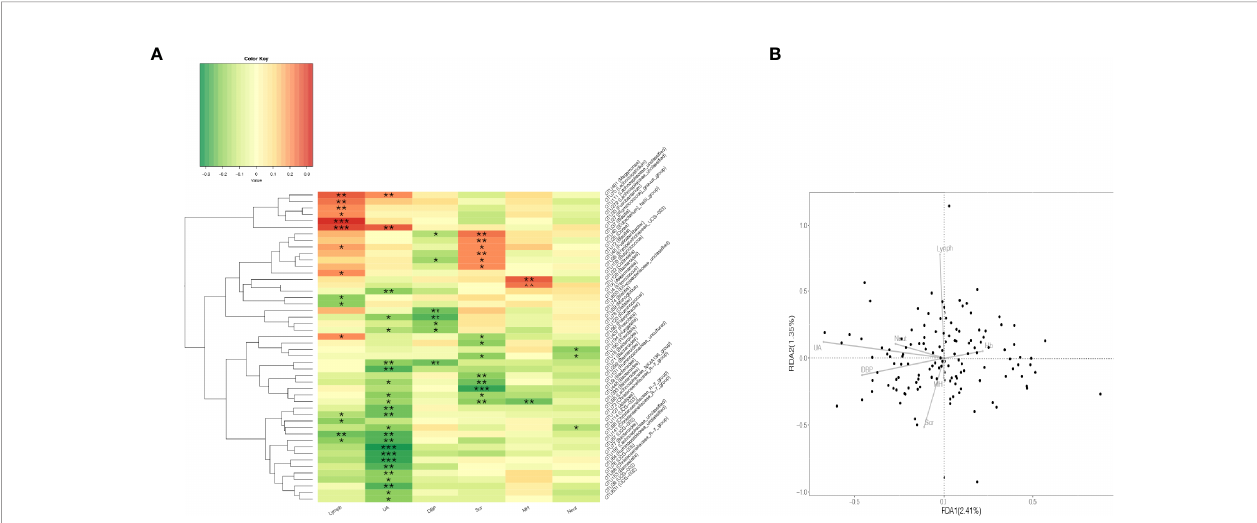
FIGURE 2 | Correlation analysis of gut microbiota and clinical indicators. (A) Heatmap of Spearman rank correlation analysis between gut microbiota and clinical indicators such as UA, Scr, Lymph, and so on. *p < 0.05; **p < 0.01; ***p < 0.001. (B) The quadrants of the arrows indicate the positive and negative correlations between the corresponding clinical indicators and the gut microbiota. The longer the connection, the greater the correlation, and vice versa . The smaller the angle, the higher the correlation. Lymph, lymphocyte; UA, uric acid; DBP, diastolic blood pressure; Scr, serum creatinine; MH, metformin history; Neut,